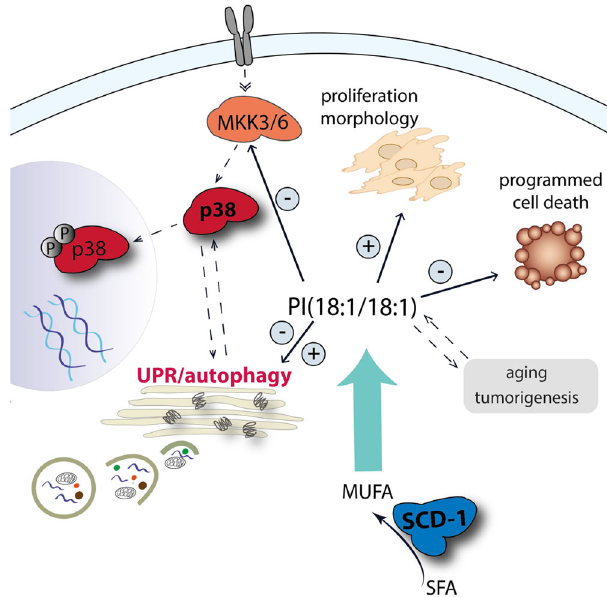
Fig. 10 Impact of the lipokine PI(18:1/18:1) on stress (-adaptive) signaling. SCD1-derived PI(18:1/18:1) (i) interferes with the UPR and autophagy, (ii) prevents the activation of p38 MAPK via MKK3/6, (iii) maintains cell morphology and supports cell proliferation, (vi) diminishes the induction of programmed cell death, and (vii) its content is regulated in various stress-related processes such as tumorigenesis, chemoresistance, aging, starvation, and